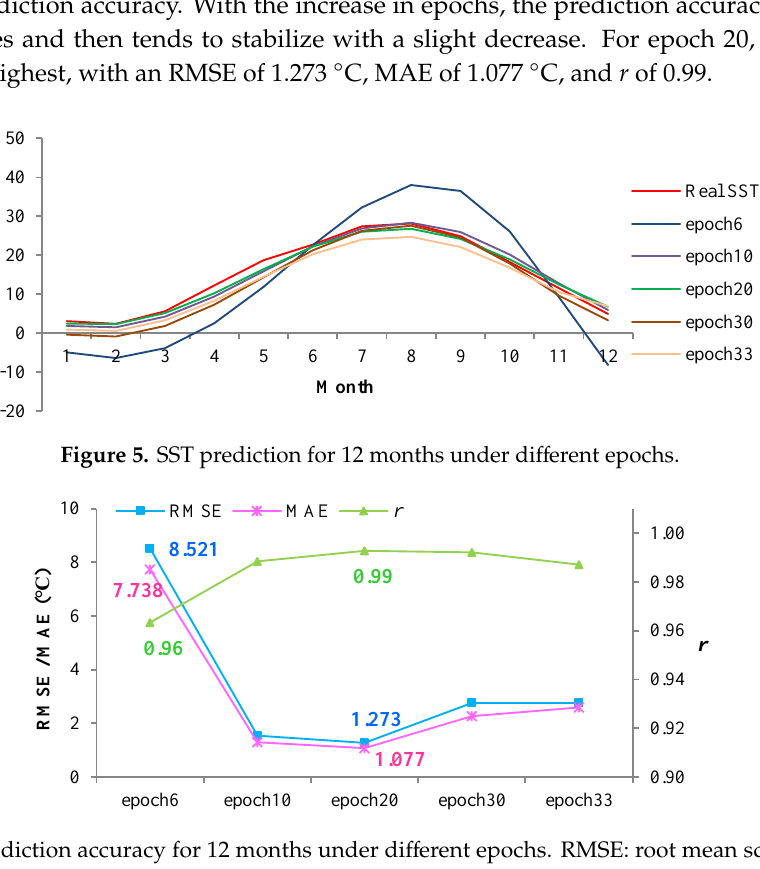
Figure 8. Prediction accuracy for 12 months under different steps. 4.3. Monthly Data Prediction